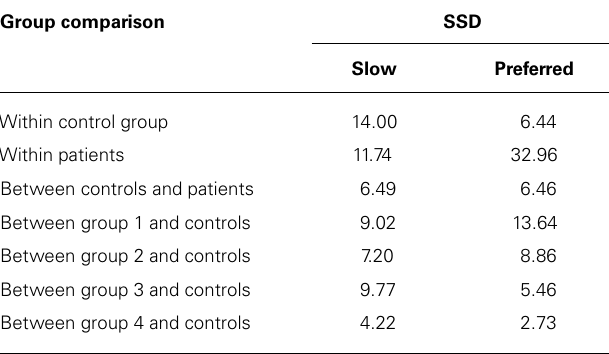
Table 2 | Cyclogram-shape differences.